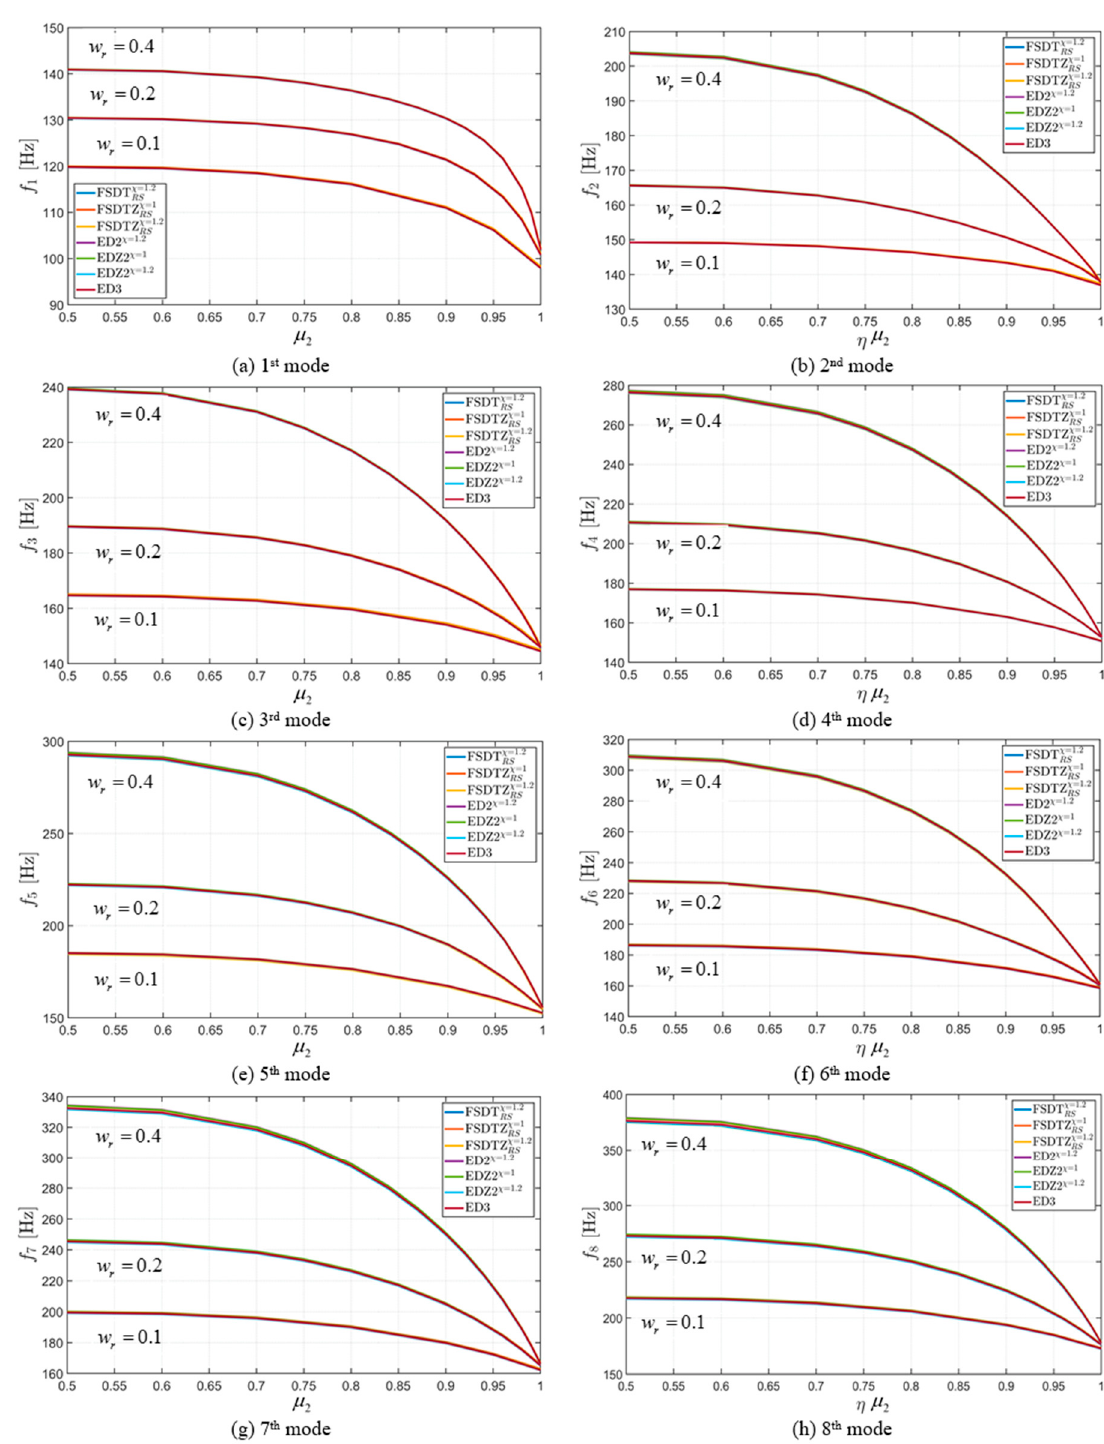
Figure 13. Frequency variations of a CCFF helicoidal surface (Figure 4c) reinforced by CNTs distributed as in Figure 5c for different mass fractions w r when varying the parameter of agglomeration µ 2 with µ 1 = 0.5. The Chebyshev-Gauss-Lobatto grid distribution was employed, with I N = 31, I M = 21. The following mode shapes are considered: ( a ) 1st mode; ( b ) 2nd mode; ( c ) 3rd mode; ( d )4th mode; ( e ) 5th mode; ( f ) 6th mode; ( g ) 7th mode; ( h ) 8th mode.